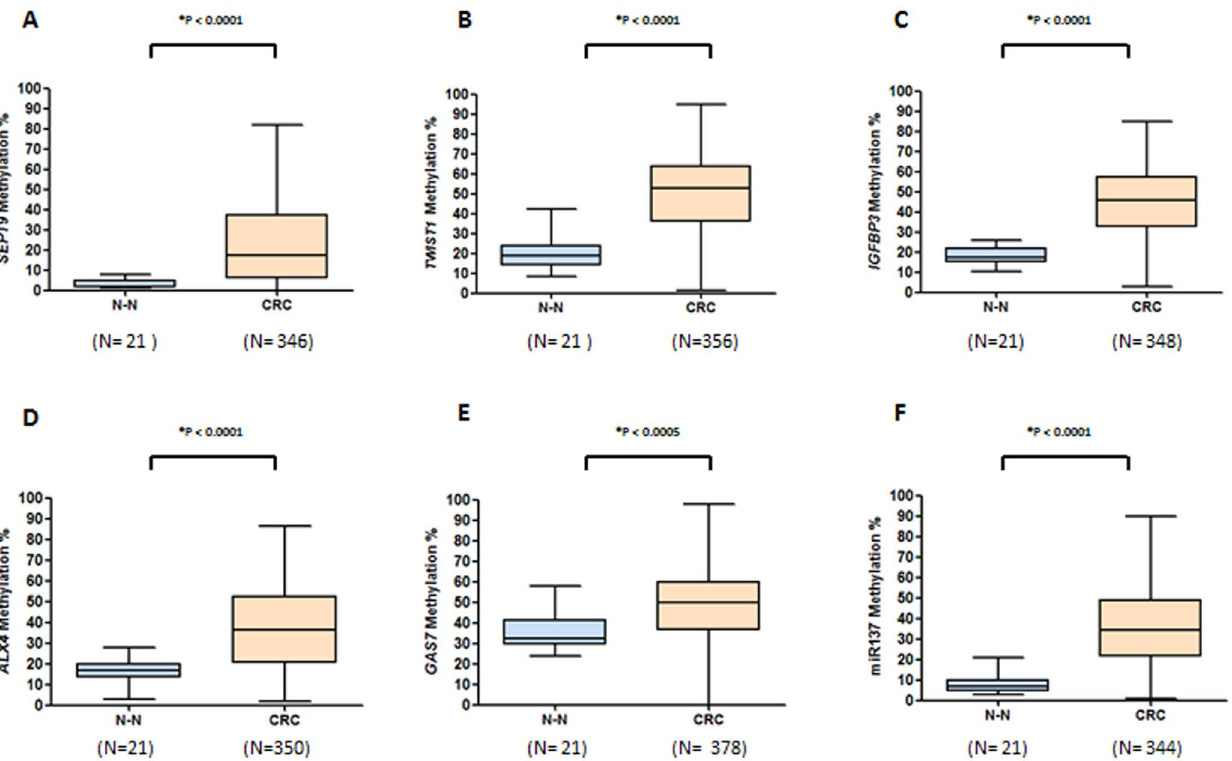
Figure 1. Comparison between levels of methylation in primary tumors vs. normal colonic mucosa. Bisulfite pyrosequencing results for methylation of SEPT9 (A), TWIST1 (B), IGFBP3 (C), ALX4 (D), GAS7 (E) and miR137 (F) genes comparing normal mucosa from healthy controls (N–N) and primary tumors from CRC patients.